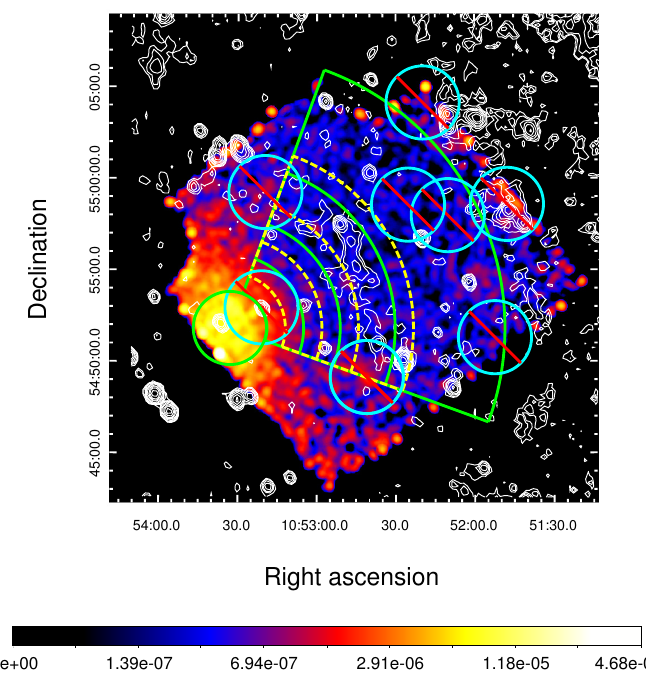
Figure 3. An X-ray image of the RXC J1053.7+5453 taken by Suzaku XIS1 in the 0.5–8.0 keV band (colors) overlaid with 1382 MHz radio contours from [7]. Green and yellow regions are used to produce the temperature profile across the relic.